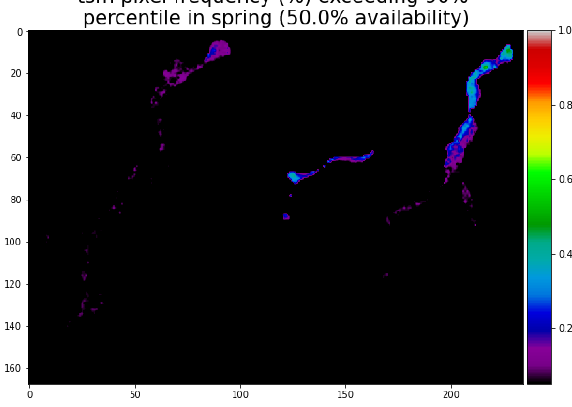
Figure 14. TSM spatial pattern map spring